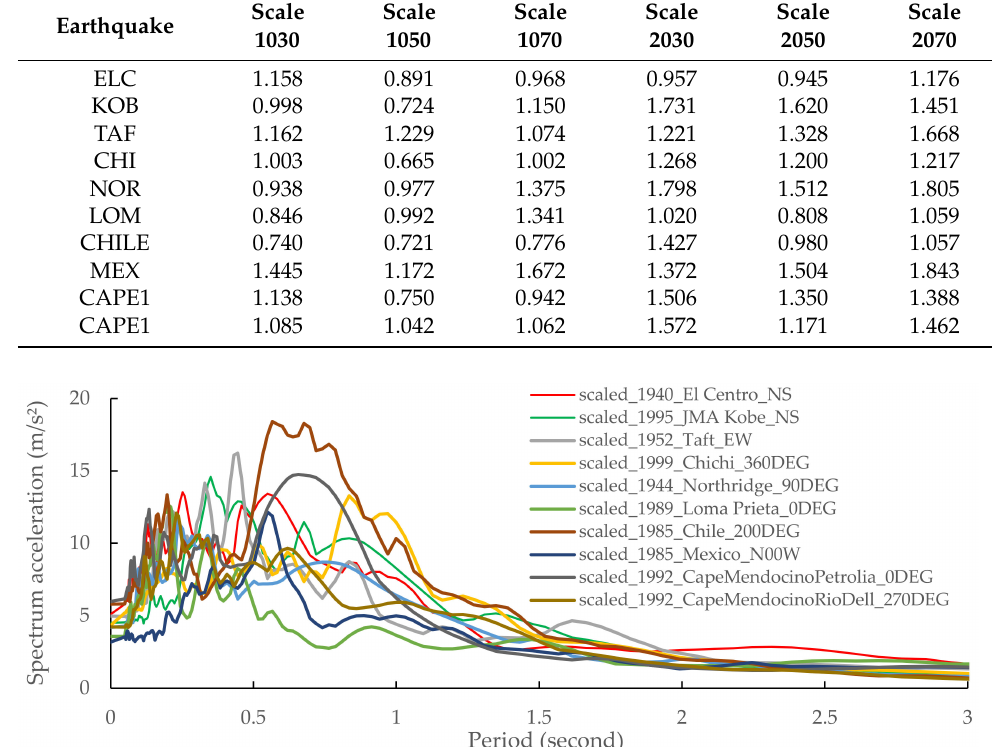
Table 5. Amplification scale of input motions to produce maximum inter-story drift of 1/75 building inter-story height.